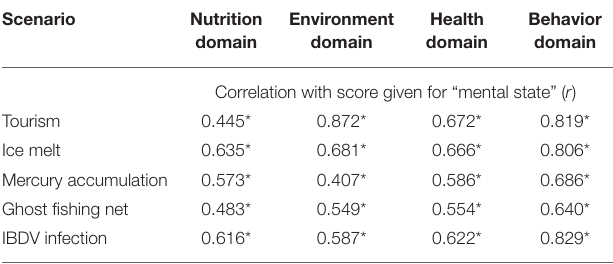
TABLE 2 | Spearman Rho coefficients of each of the four physical domains and the mental state domain for each of the five